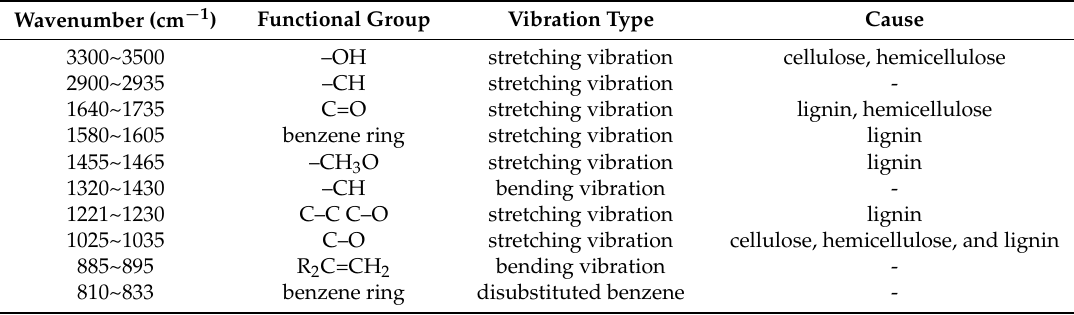
Table 4. Absorption band assignment in the infrared spectrum of almond shell and poplar.